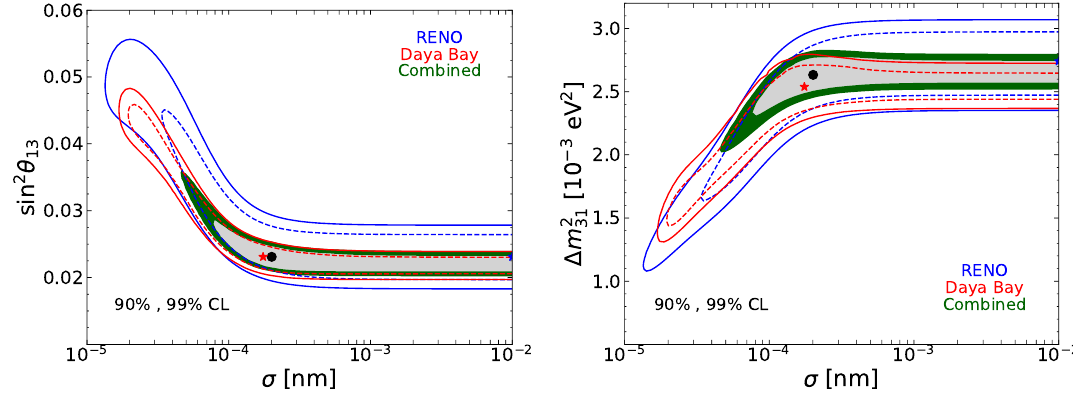
Figure 3 . 90 and 99% CL (2 d.o.f.) allowed regions in the (cid:27) -sin 2 (cid:18) 13 (left) and (cid:27) -(cid:1) m 2 planes for RENO (blue lines), Daya Bay (red lines) and the combination of the two ((cid:12)lled regions). Stars denote the best-(cid:12)t values from the analysis of a single experiment on its own (the best-(cid:12)t value for RENO lies at (cid:27) (cid:24) 10 (cid:0) 2 nm), while the black dot is the best-(cid:12)t point obtained from the combined